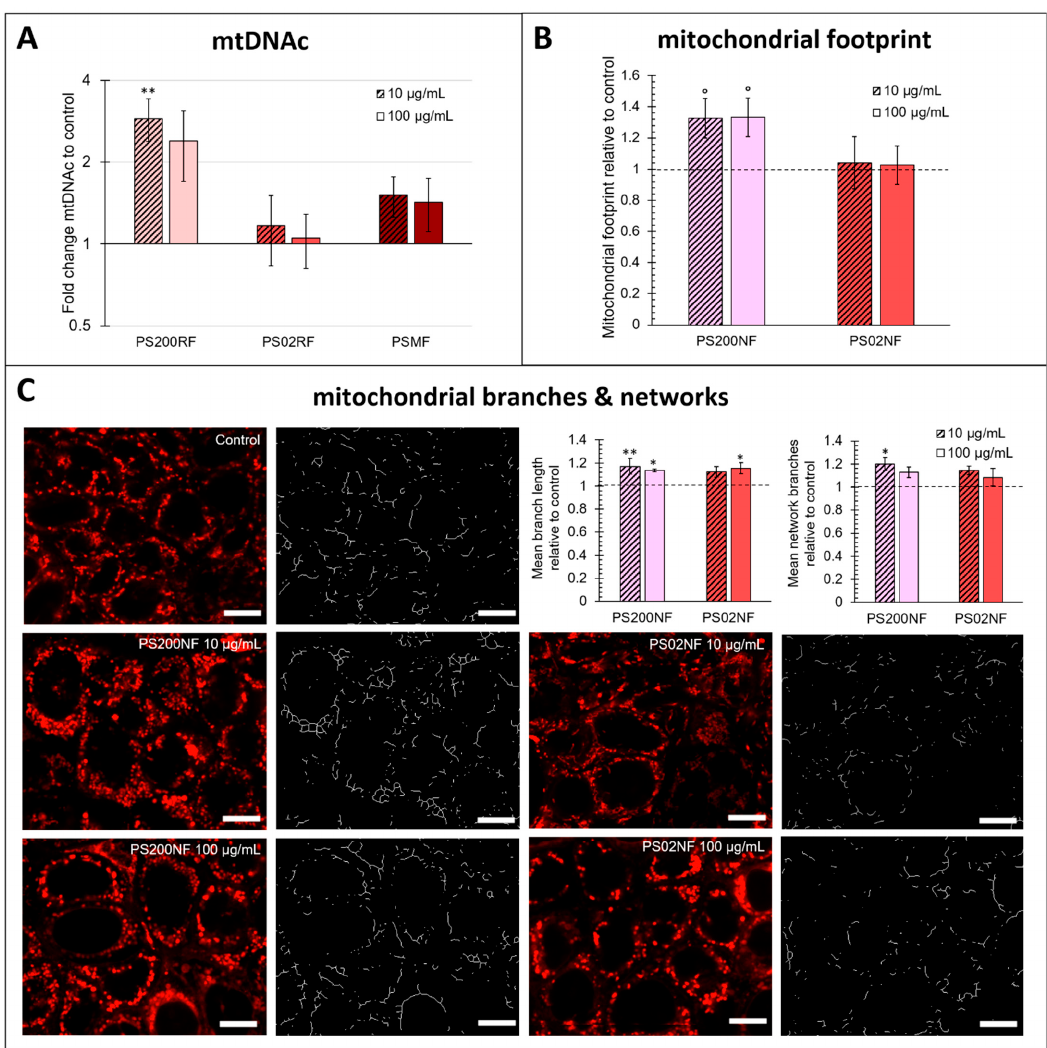
Figure 6. Effects of PS-MPs on mitochondrial functioning in a Caco-2 monolayer. ( A ) Mito- chondrial DNA content (mtDNAc) (fold change to control) of a Caco-2 monolayer after 24 h of exposure to 10 and 100 µ g/mL PS200RF, PS02RF, and PSMF ( n = 12 from 2 independent experiments). ( B ) Mitochondrial footprint (relative to control) of a Caco-2 monolayer after 24 h of exposure to 10 and 100 µ g/mL PS200NF and PS02NF ( n = 6 from 2 independent experiments). ( C ) Representative images of the different conditions with MitoTracker Red CMXRos and their corresponding skeleton assessed by the MINA tool in ImageJ according to Valente et al. 2017 [29]. Scale bar: 10 µ m. The graphs represent the mean branch